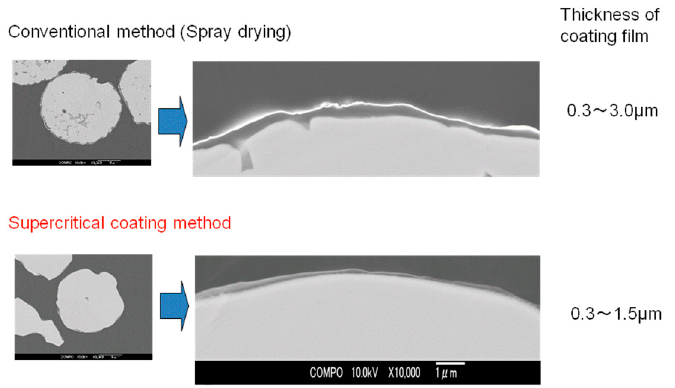
Figure 8. Scanning electron micrographs of the cross sections of ferrite fine particles coated with silicone resin S1 using conventional and supercritical coating methods at 40 °C and 25 MPa.